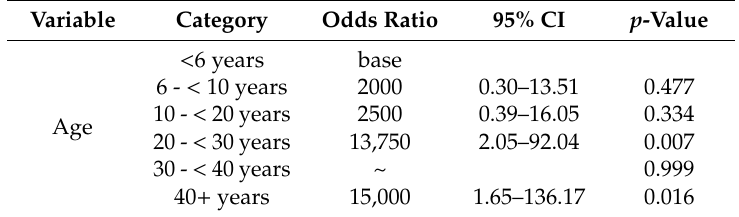
Table 9. Final logistic regression results for variables associated with health checks resulting in actionable outcomes for gibbons undergoing elective health checks between 2011 and